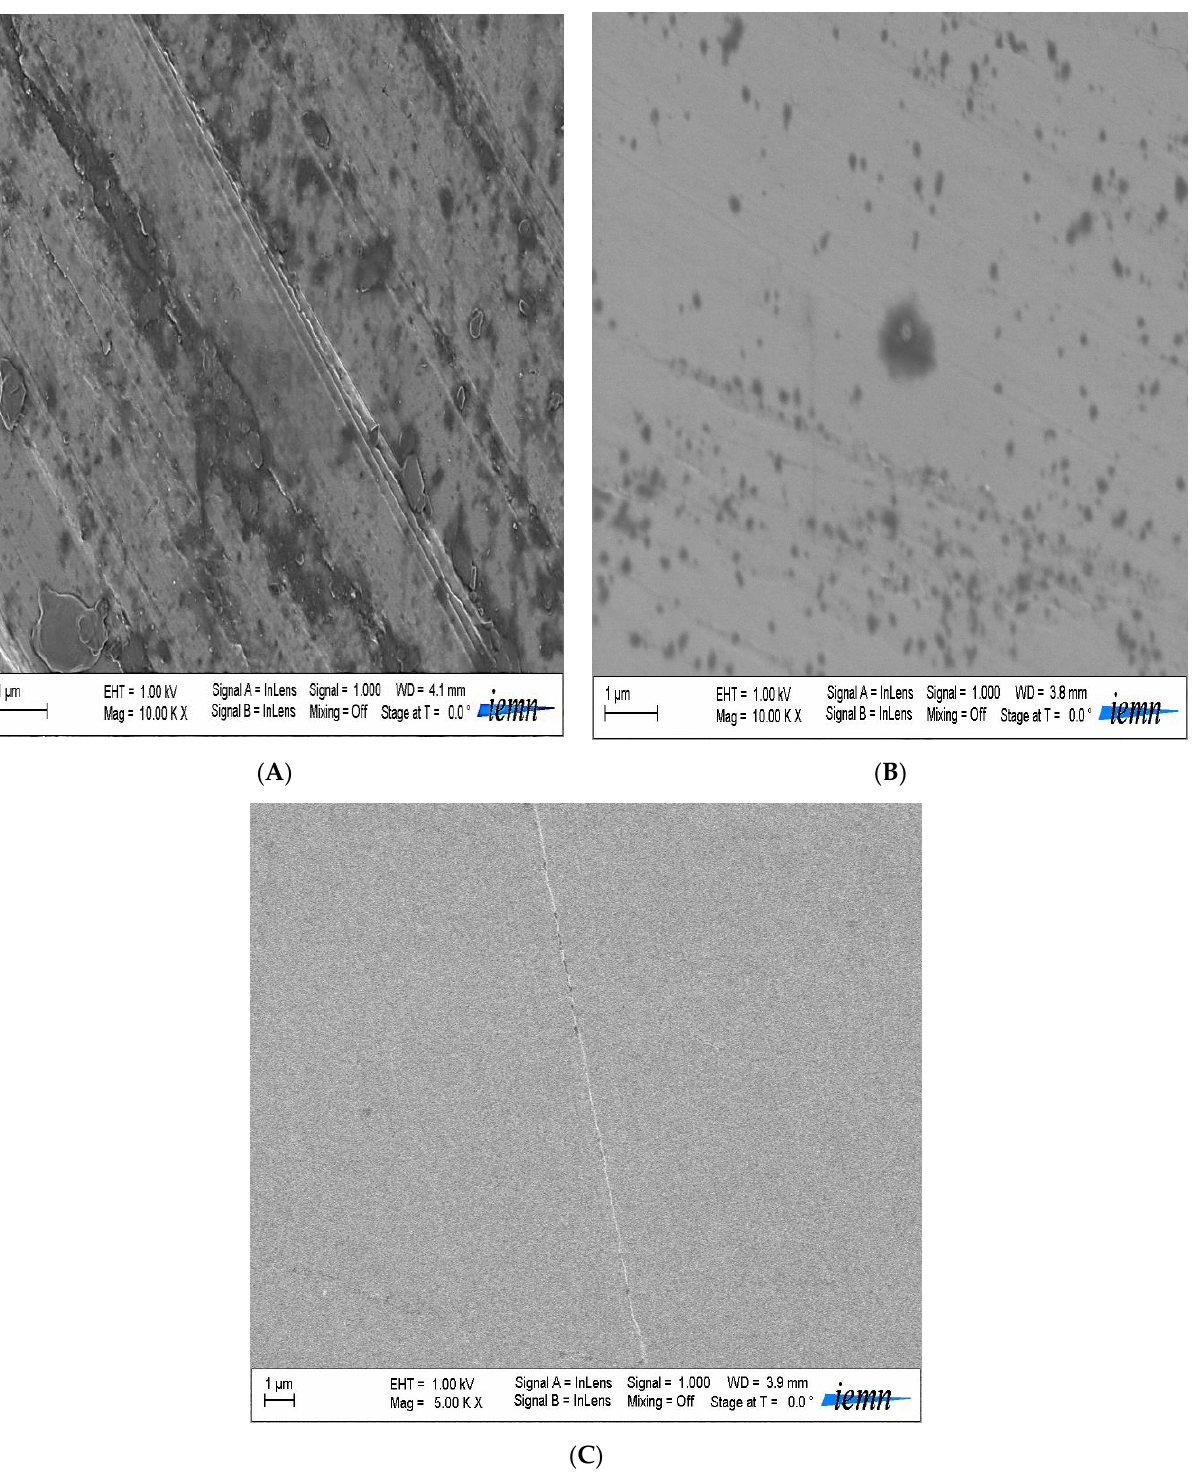
Figure 8. SEM images of the coated steel in the different soil extracts, ( A ) clay, ( B ) soil, and (C ) sand.